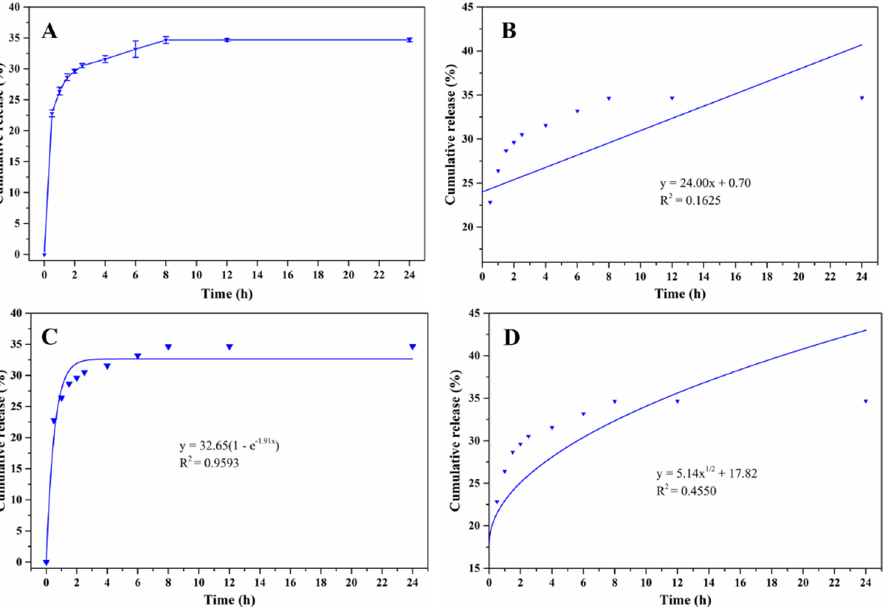
Figure 8. The cumulative release curve of carvacrol microcapsules in food simulant ( A ) and three release fitted curves: Zero-order ( B ), First-order ( C ), and Higuchi ( D ).